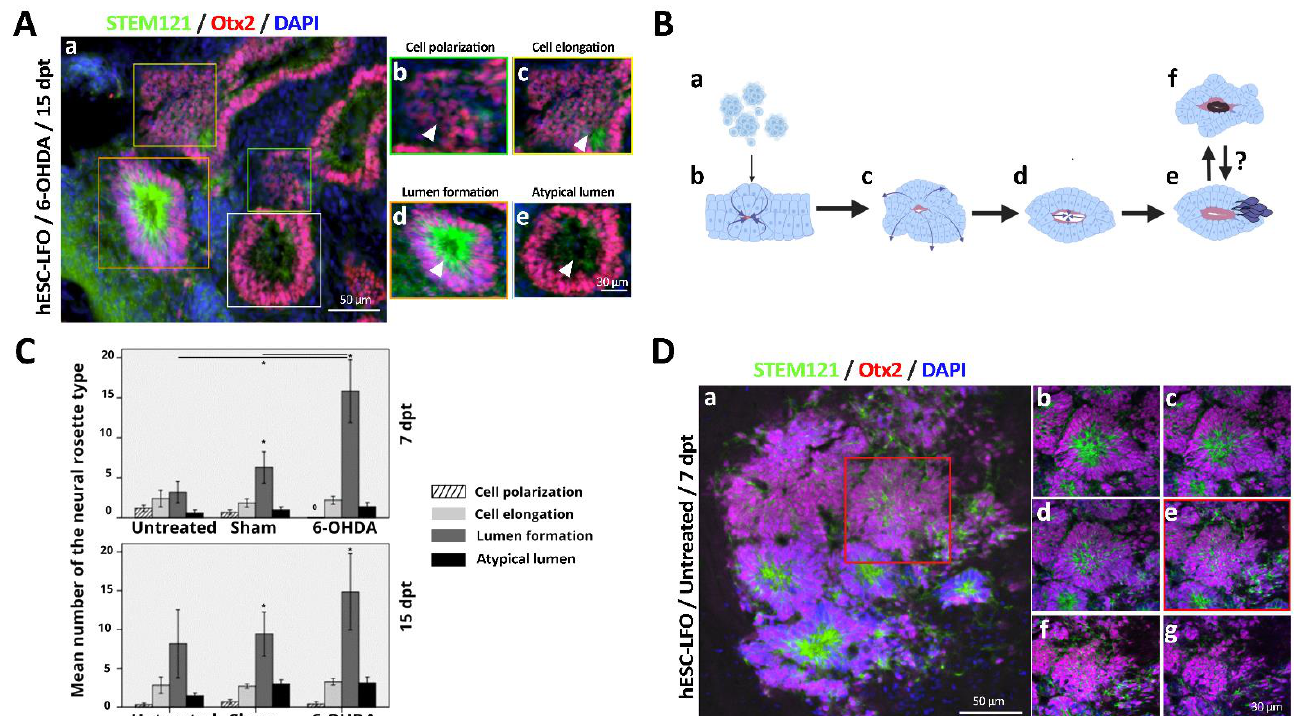
Figure 4. Neural rosettes of grafted hESC-LFO EBCs are mainly present in the lumen formation stage. ( A ) Representative image of different types of neural rosettes according to the STEM121-Otx2 labeling: ( a ) 20× transplantation image of the hESC-LFO EBCs into 6-OHDA-lesioned rat at 15 dpt with various types of neural rosettes; ( b ) cell polarization; ( c ) cell elongation; ( d ) lumen formation and ( e ) “atypical lumen”. ( B ) Graphical representation of neuronal differentiation of neural rosettes formed from hESC EBCs transplanted into the SNpc: ( a ) single cells and small clusters of EBCs are transplanted into the SNpc; ( b ) transplanted cells attach; ( c ) polarization, cells organize in an apical-basal conformation; ( d ) cell elongation, cells acquire an elongated morphology that allows the development of the lumen; ( e ) neural rosettes with lumen formation, a luminal part is formed, characterized by expression of the tight-junction marker ZO-1. The apical space begins to close, and cells migrate to the apical area; ( f ) unknown factors promote the generation of neural rosettes classified as atypical lumen, which present reduced STEM121 signal and small spaces devoid of cells in the lumen zone (white arrow). It is unknown whether ( e ) the lumen formation stage generates the ( f ) atypical lumen stage or vice versa. ( C ) Mean number of the neural rosettes type of untreated, sham, and 6-OHDA-lesioned rats at 7 and 15 dpt. Quantification of neural rosettes classification was performed using tissue marked with Otx2 colocalizing with STEM121. Error bars represent standard deviation. (*) indicates a significance of p < 0.05 calculated by one-way ANOVA. ( D ) Representative image of neural rosettes from an untreated rat at 7 dpt expressing Otx2 and STEM121. ( a ) 20 × magnification of the hESC-LFO transplantation with neural rosettes. The red square highlights the area of ( b – g ) magnification. ( b – g ) Sliding levels from the top ( b ) to bottom ( g ) at 40 × magnification of the red square in ( a ); 29 slides were captured with a width of 204.8 µ m. ( e ) The image corresponds to the middle of the stack and is at the same slide level as the image in ( a ). Otx2: orthodenticle homeobox 2; dpt: days